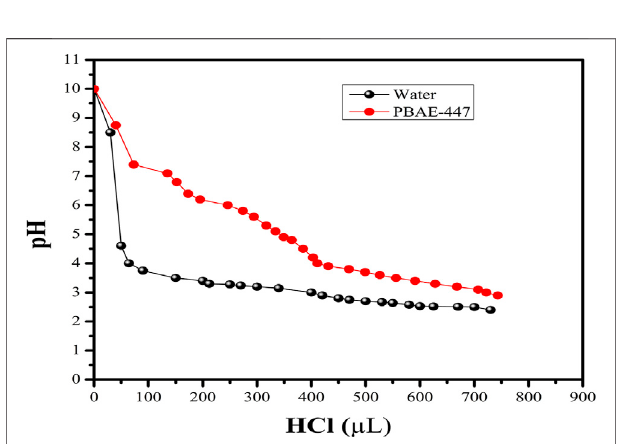
FIGURE 3 | Buffering capacity of the P β AE-447 is determined by titration.